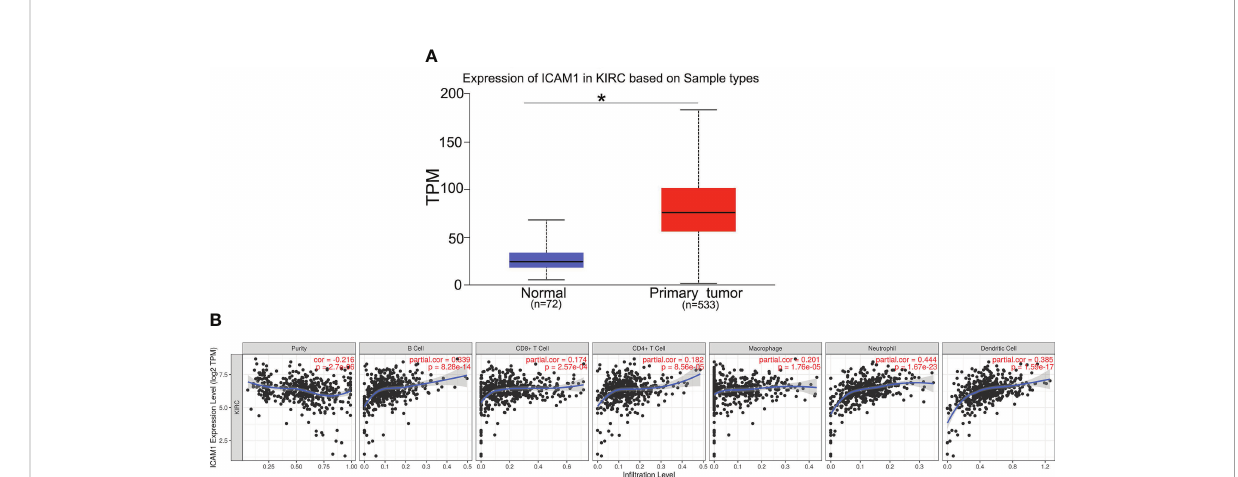
FIGURE 5 Expression of ICAM1 in KIRC patients. (A) ICAM1 was upregulated in primary tumors (p < 0.001). (B) Correlation analysis of ICAM1 expression and in fi ltration levels of immune cells in KIRC tissues using TIMER. ICAM1 expression in KIRC tissues was negatively correlated with tumor purity and positively correlated with the in fi ltration levels of B cells, CD8+ T cells, CD4+ T cells, macrophages, neutrophils, and dendritic cells. (KIRC, kidney renal clear cell carcinoma; TPM, transcripts per million.).